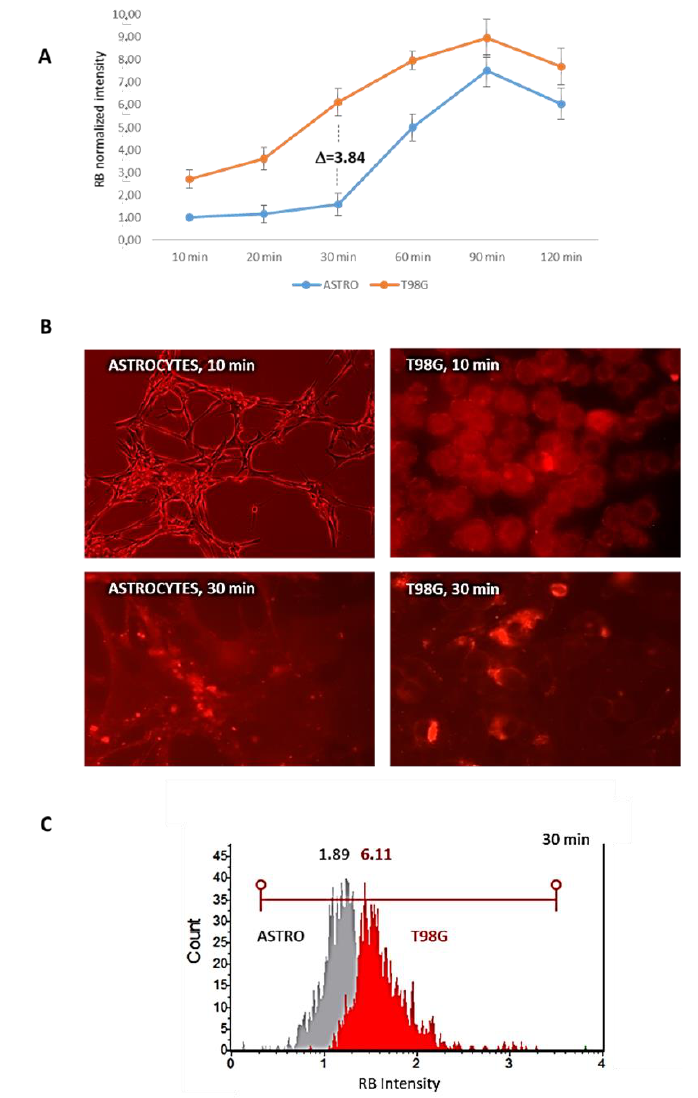
Figure 8. Time kinetics of RB internalization during starvation. ( A ) RB (12.5 µ M) was administered during HBSS starvation in normal rat astrocytes and T98G cells and evaluated by Guava Muse Cell Analyzer cytometry (Luminex) at different time intervals (i.e., 10–20–30–60–90–120 min p.t., X axis). Values, obtained in three independent experiments, are normalized to astrocytes at time 0 (reported in Y axis). SD are highlighted as vertical bars. ( B ) RB was visualized in astrocytes and T98G cells at 10 and 30 min p.t. using a Nikon Eclipse TS100 inverted florescence microscope at 20 × magnification (RB: G2A blocking filter; exc. = 535/50 nm; dichr. mirr. = 577 nm; barrier = 580 nm). ( C ) Comparison of cytofluorimetric plots of astrocytes (gray) and T98G (red) cells ( n = 10,000) in RB intensity values at 30 min HBSS